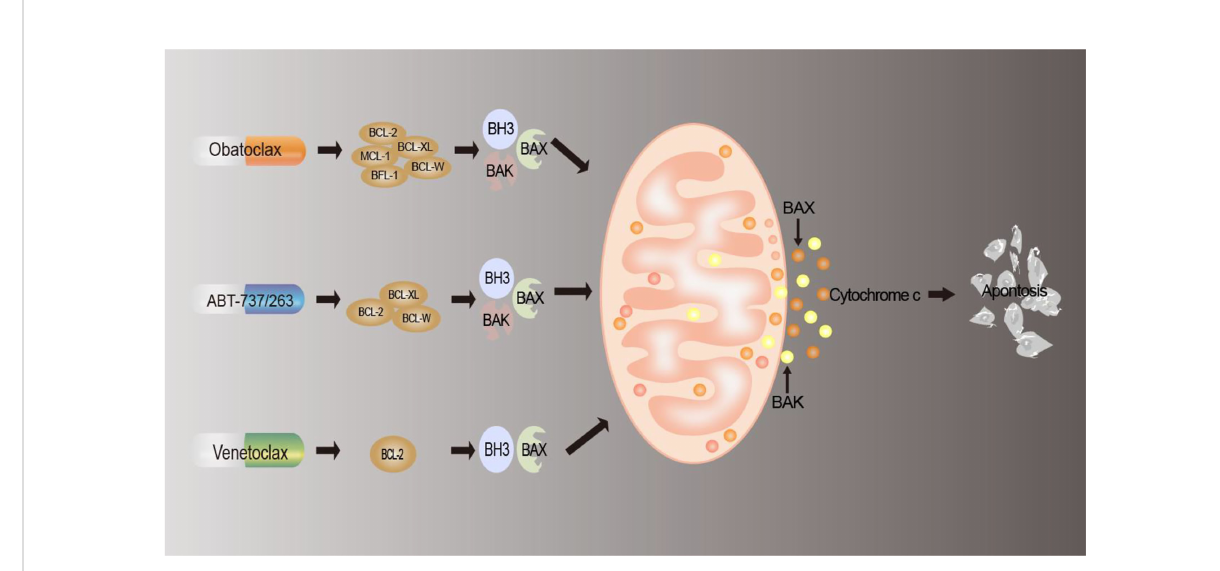
FIGURE 3 Mechanism of BCL-2 drug action. BCL-2 inhibitors interact with members of the BCL2 family of proteins to reduce the production of anti- apoptotic proteins, block the anti-apoptotic defense mechanism of tumor cells, replace and release pro-apoptotic proteins, induce apoptosis, and thus achieve antitumor